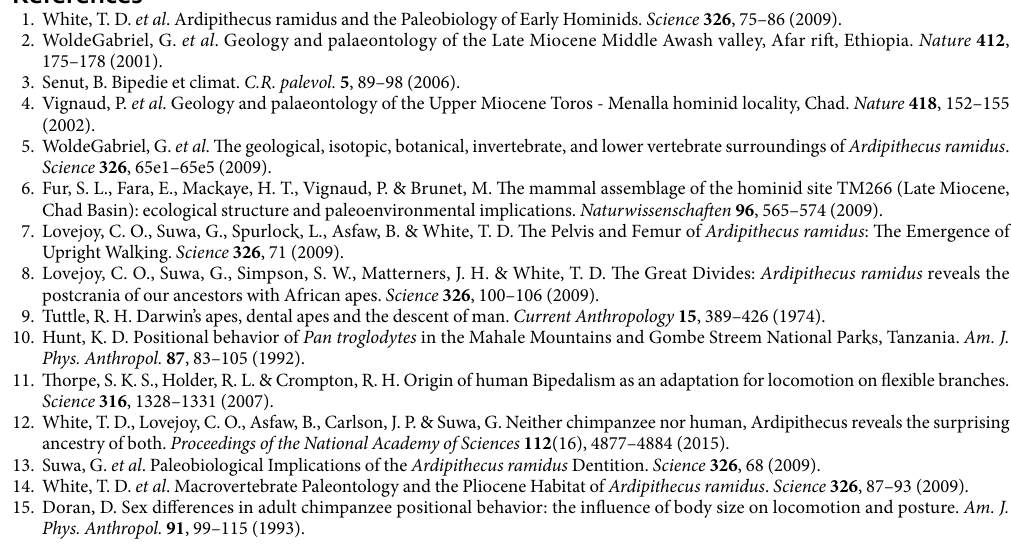
where Pi is the basal area of tree i (cm 2 ), and Fi is the fruiting score of tree i (0–3). The distribution of fruiting trees was tested using Morisita’s Index of dispersion as a unit 50 m in length and randomness was estimated. ∑ where χ 2 is the test statistic for Morisita’s index of dispersion (chi-square distribution), n is sample size, I δ is Morisita’s index of dispersion, ∑ x = sum of the fruiting trees. In Wamba, the fallen fruit census data of the Wamba research team, which ran along the same trail as the FAI transects, was used for calculating Morisita’s Index. The sample sizes were 41 (2,050 m) at Bossou and 56 (2,800 m) at Wamba. MCMCglmm (MCMC generalized linear mixed models) in R package was performed to estimate factors affecting utilization height by Pan species. Family = “ordinal”, nitt = 1,000,000, thin = 100, burnin = 100,000, were set for the analysis.